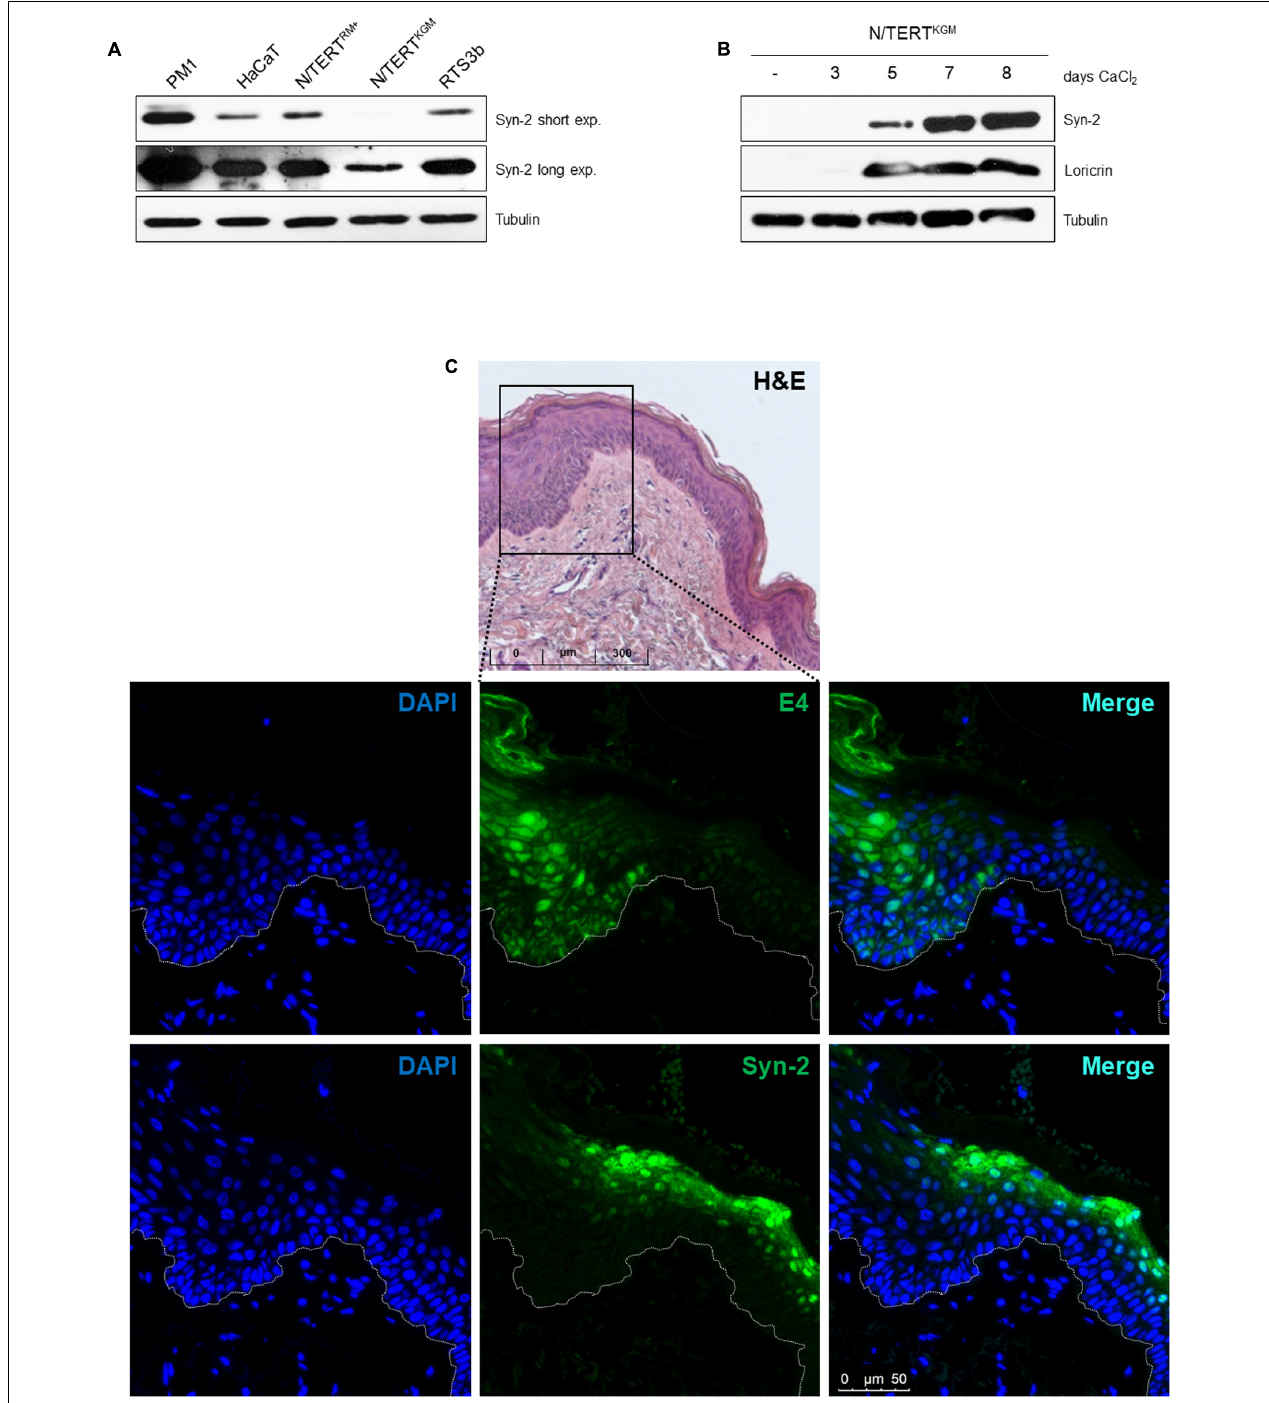
FIGURE 2 | Differentiation dependent expression of Syntenin-2 in skin keratinocytes. (A) Representative Western blot showing Syntenin-2 levels in total cell extracts of the keratinocyte cell lines PM1, HaCaT, RTS3b and isogenic N/TERT cells either cultured in RM+ (N/TERT RM + ) or in KGM-Gold (N/TERT KGM ). Equal loading was confirmed by immunoblotting for Tubulin. (B) Representative Western blot of Syntenin-2 levels in total cell extracts of N/TERT KGM treated with 2 mM CaCl 2 for up to 8 days. Calcium induced keratinocyte differentiation was confirmed by Western blotting for Loricrin. Equal loading was confirmed by immunoblotting for Tubulin. (C) Representative immunofluorescence staining images detecting Syntenin-2 in EV-derived skin lesions. The skin area with productive betaPV infection was identified by anti-E4 staining. Nuclear counterstain was performed using DAPI. Syntenin-2 expression is present in suprabasal keratinocytes of non-lesional/E4-negative EV skin and absent in an E4-positive skin tumor. Top lane: H&E staining of the EV tissue analyzed.